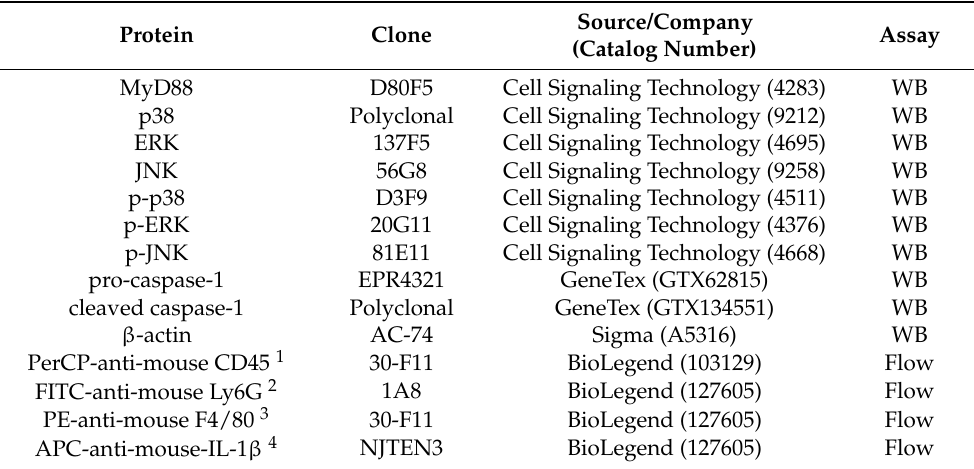
Table 1. Antibodies used for Western blotting (WB) and flow cytometry (Flow). Protein Clone